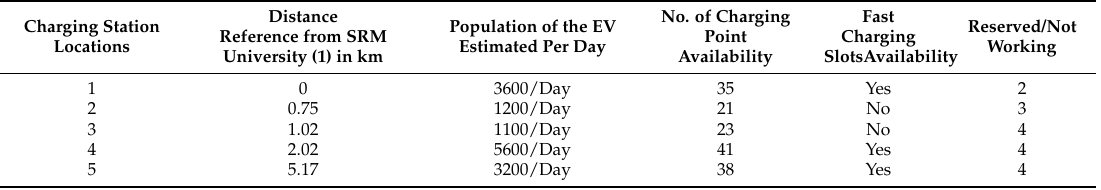
Table 3. Characteristics of charging stations with reference from Google Map.